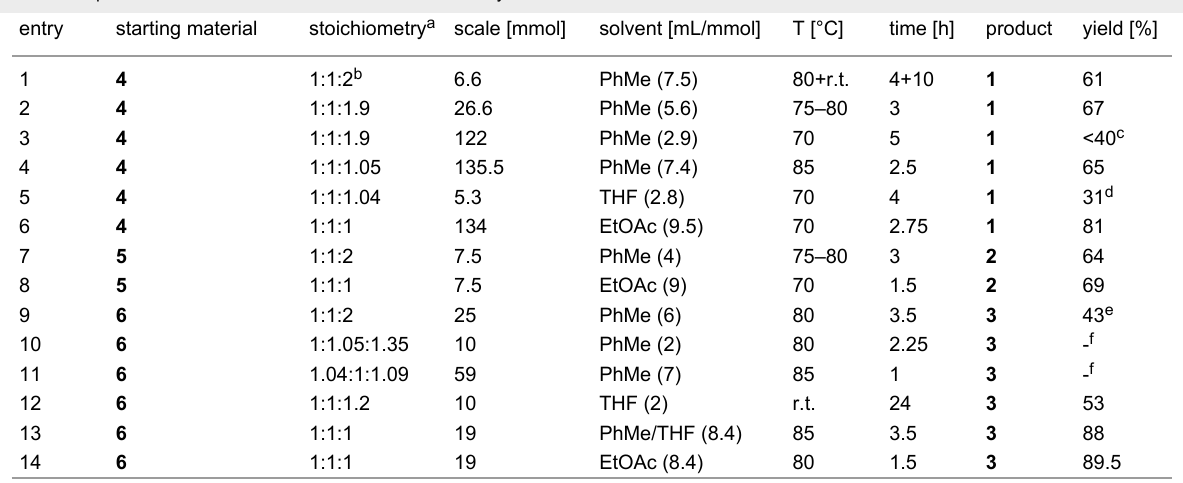
a) Diazadiene/paraformaldehyde/TMSCl. b) Addition of TMSCl in two portions, in all other cases slow, dropwise addition. c) Impure product. d) Yield after recrystallization from acetone/tBuOMe; raw yield 60%. e) Losses due to washing away of colored impurities with acetone. f) Brown, impure material was obtained.